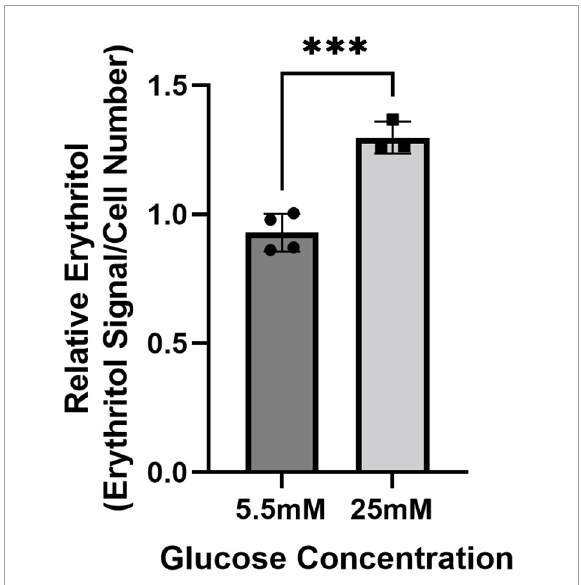
FIGURE2 Intracellular erythritol in HK-2 cells is increased in high-glucose media. Intracellular erythritol was measured in HK-2 cells exposed to 5.5 or 25 mM glucose media for 48 h ( n = 4). Data is normalized by internal standard and cell number, shown as mean ± SD, and analyzed by unpaired t -test. ∗∗∗ p <